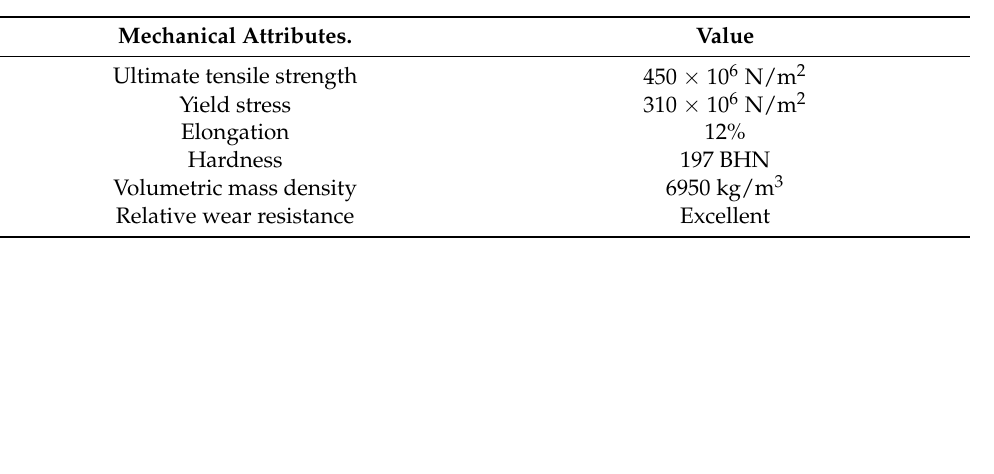
Table 2. Mechanical properties of pearlitic SG iron (450/12